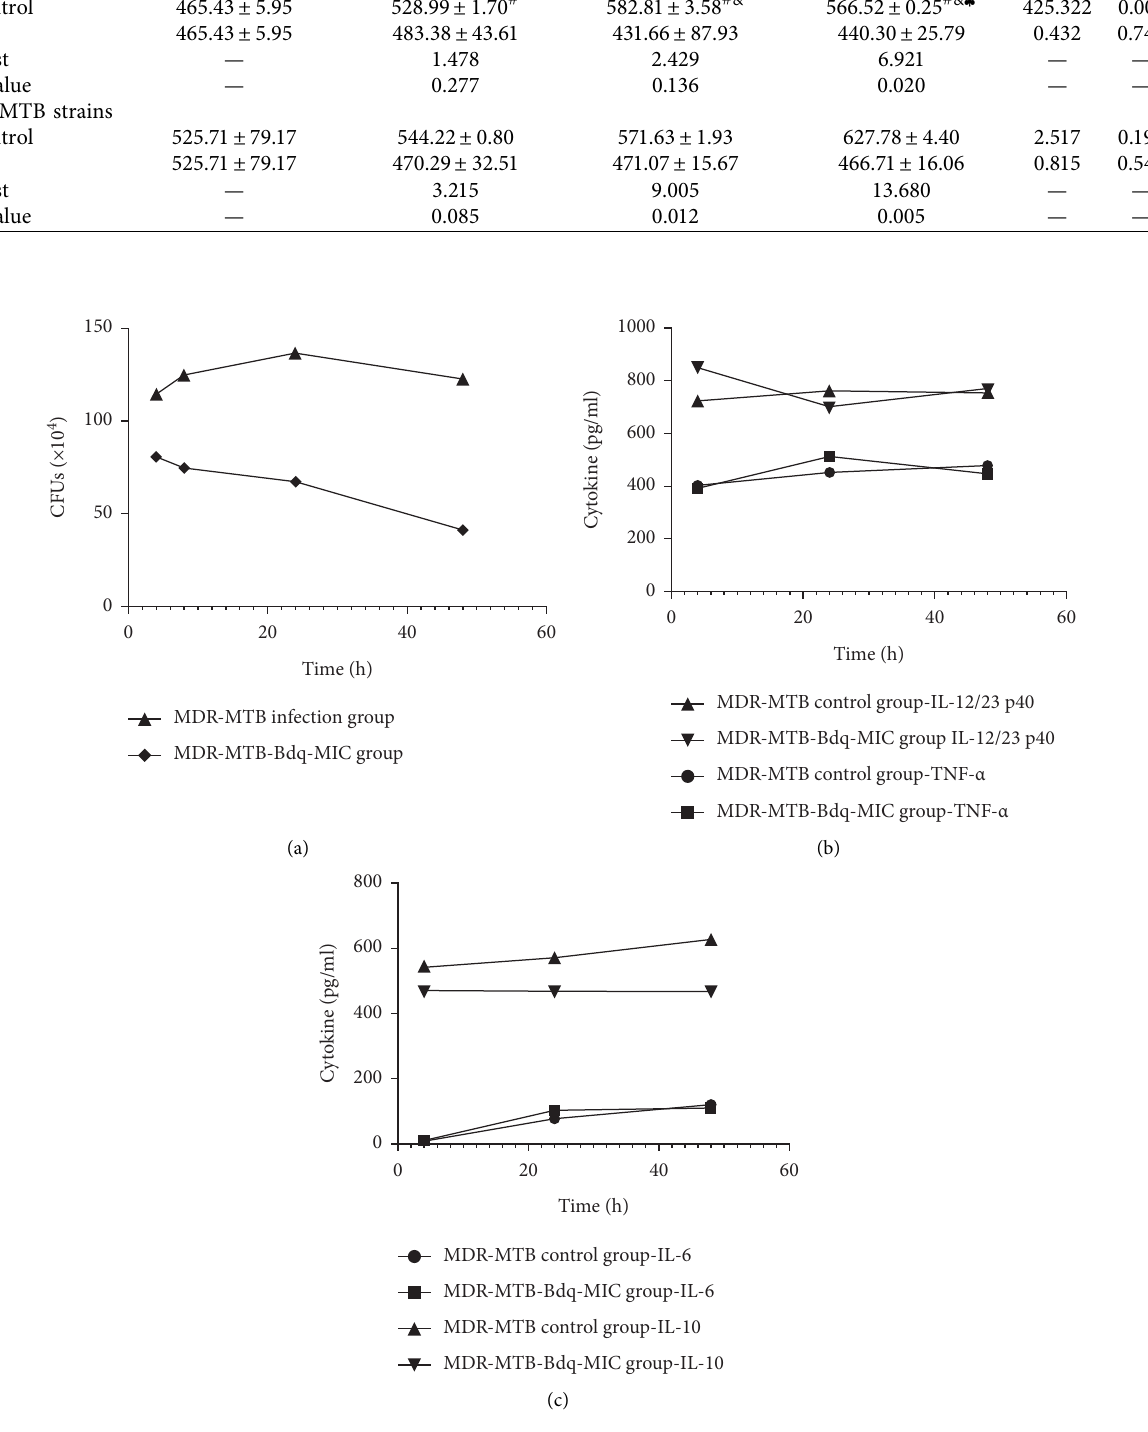
Figure 2: The relationship between Th1/Th2 cytokine levels and intracellular CFUs of MDR-MTBs-infected macrophages after Bdq administration. (a) Intracellular CFUs detected in macrophages infected with MDR-MTB after Bdq treatment. (b) Levels of Th1 cytokine in culture supernatant of macrophages infected with MDR-MTB after Bdq administration. (c) Levels of Th2 cytokine in culture supernatants of macrophages infected with MDR-MTB after Bdq